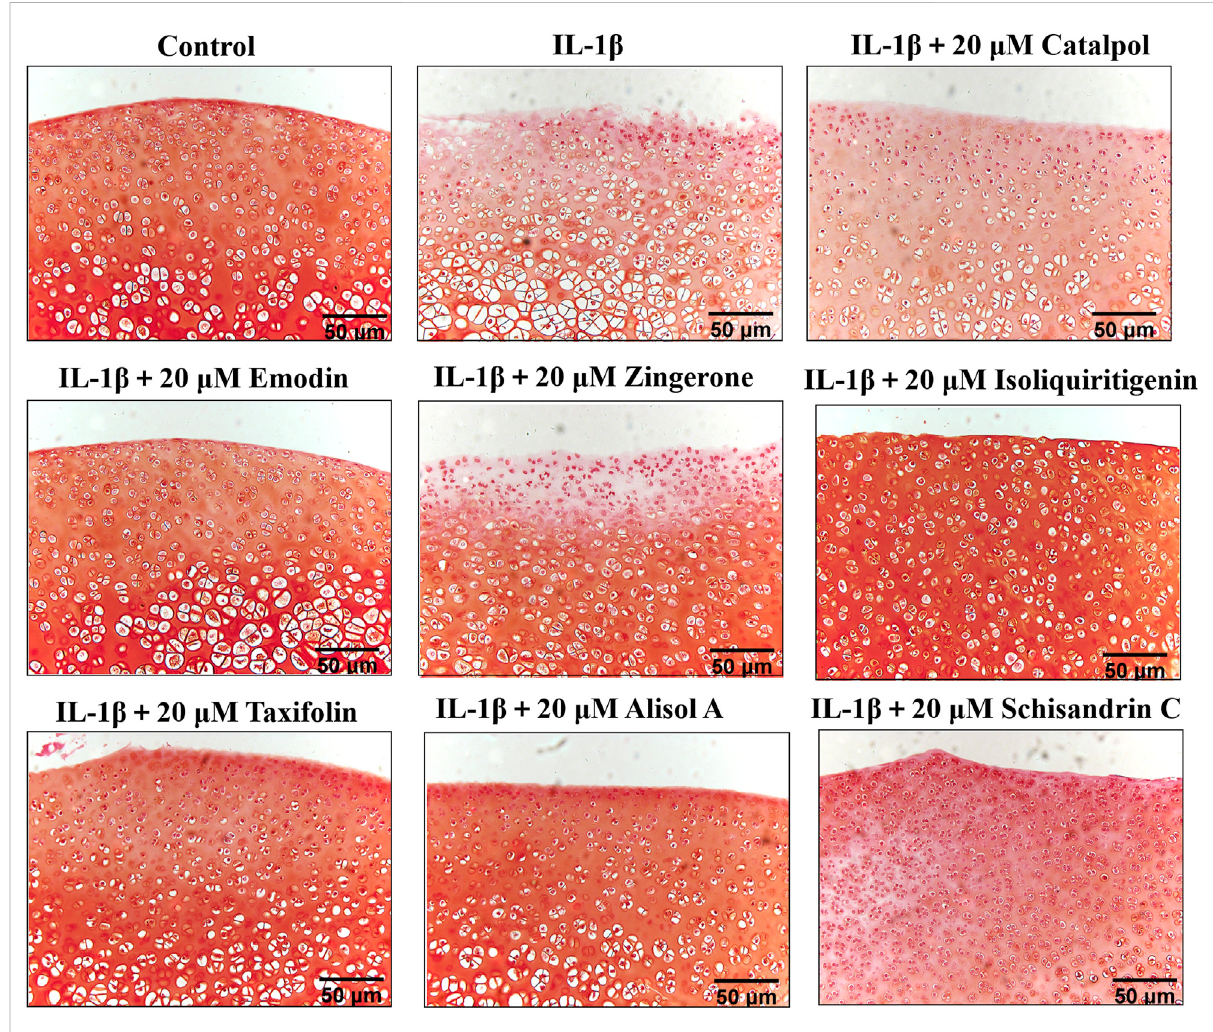
FIGURE 6 Rat cartilage explants were exposed to 20 μ M active constituents with IL-1 β (10 ng/ml) for 3 days and stained with Safranin O